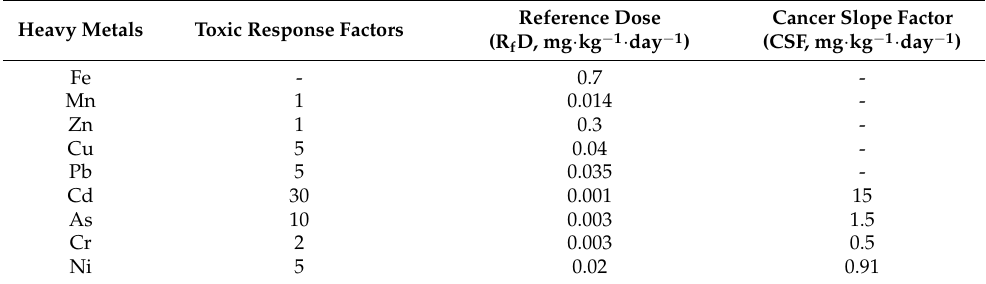
Table 4. Toxic response factor, reference doses (R f D), and cancer slope factor (CSF) for heavy metals. Heavy